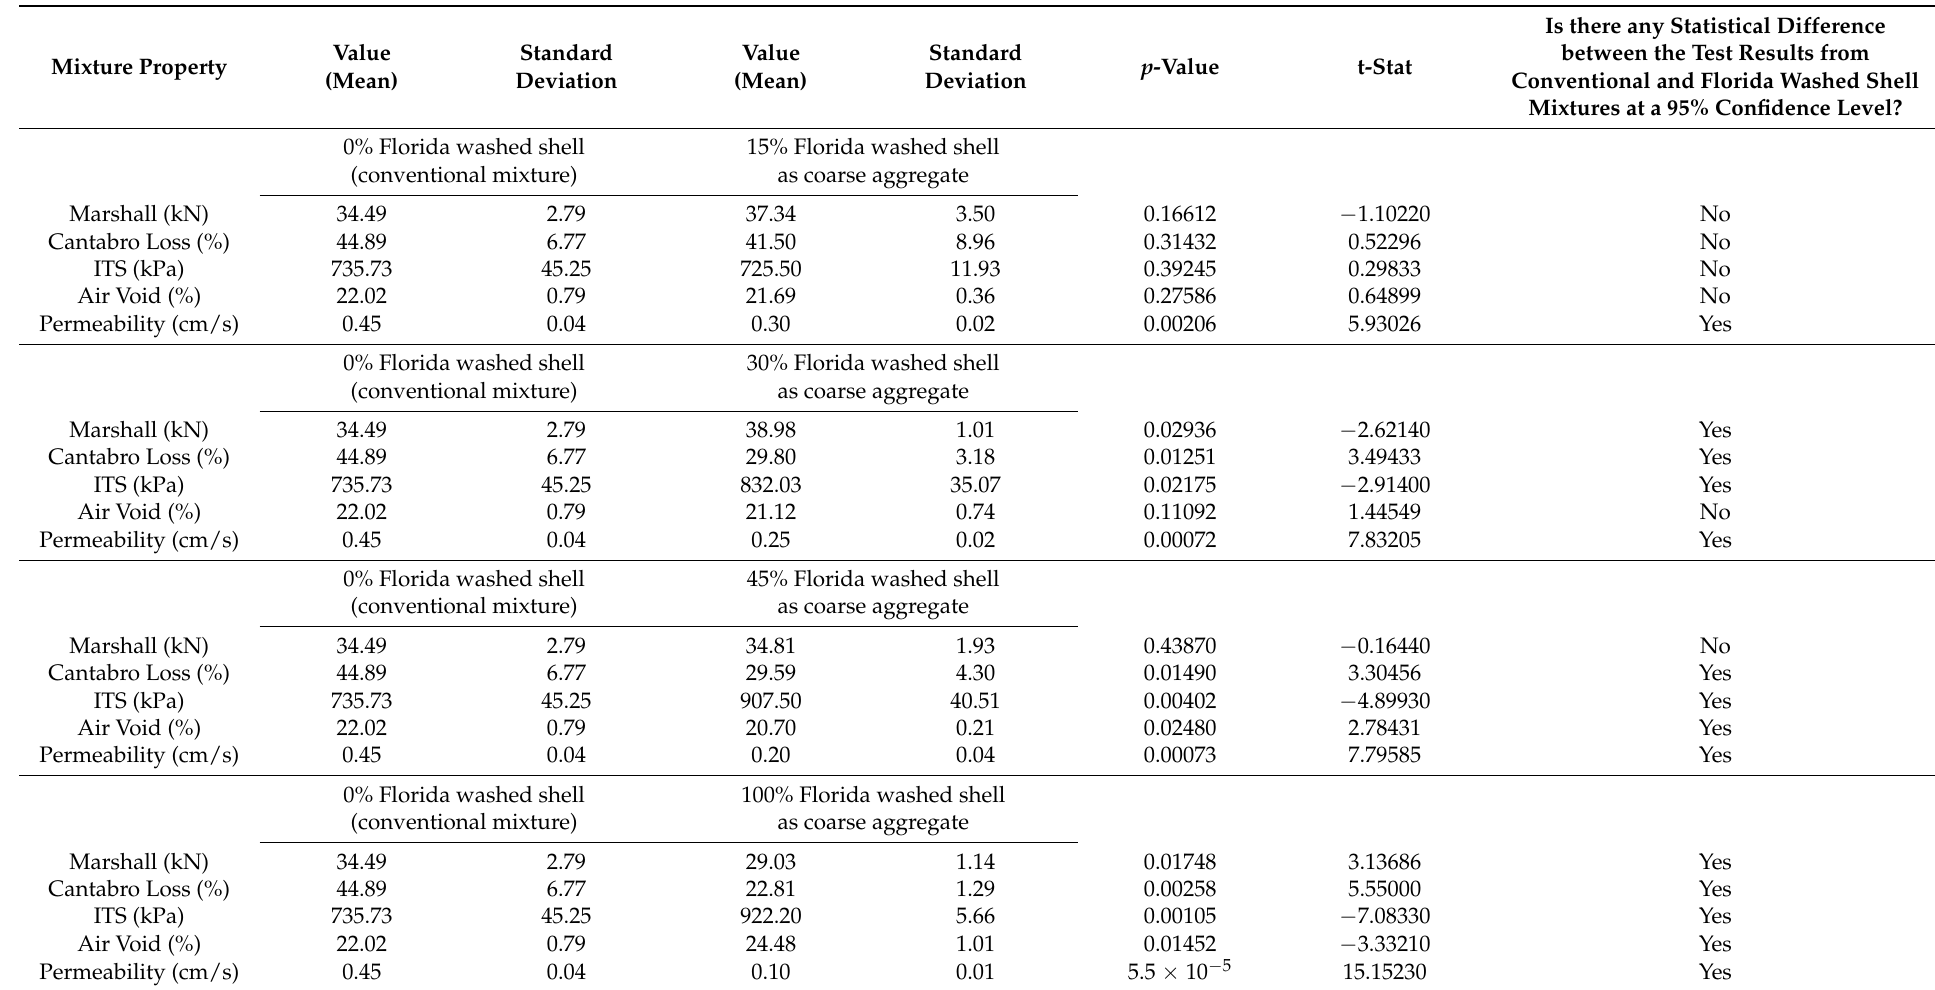
Table 4. Statistical analysis of laboratory test results from open-graded asphalt mixtures of 12.5 mm